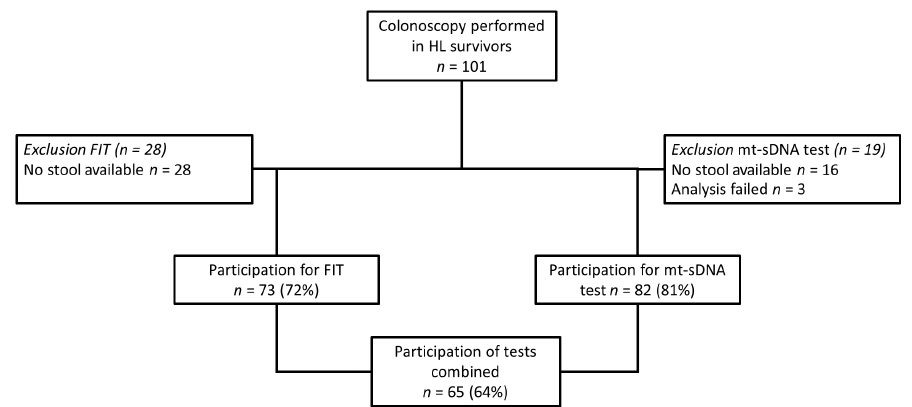
Figure 1. Study flow of Hodgkin lymphoma (HL) survivors who underwent a colonoscopy and participated in the fecal immunochemical test (FIT) and / or multi-target stool DNA test (mt-sDNA). Table 1. Patient characteristics of Hodgkin Lymphoma (HL) survivors who underwent a colonoscopy and performed a fecal immunochemical test (FIT) and/or multi-target stool DNA test (mt-sDNA) .